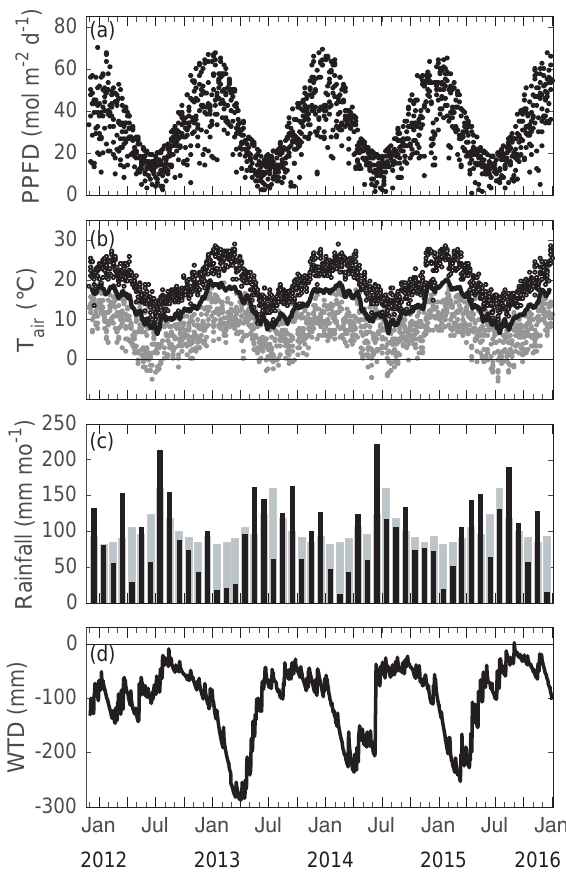
Figure 1. Meteorological and hydrological variables at Kopuatai bog from December 2011 to December 2015. (a) Daily total incom- ing photosynthetic photon flux density (PPFD), (b) daily minimum (gray dots), maximum (black dots), and 15-day running mean air temperature ( T air ) (line), (c) monthly total rainfall (black bars) and monthly climatologies (1980–2010) taken from a nearby climate station (gray bars), and (d) daily mean water table depth (zero line is the peat surface).